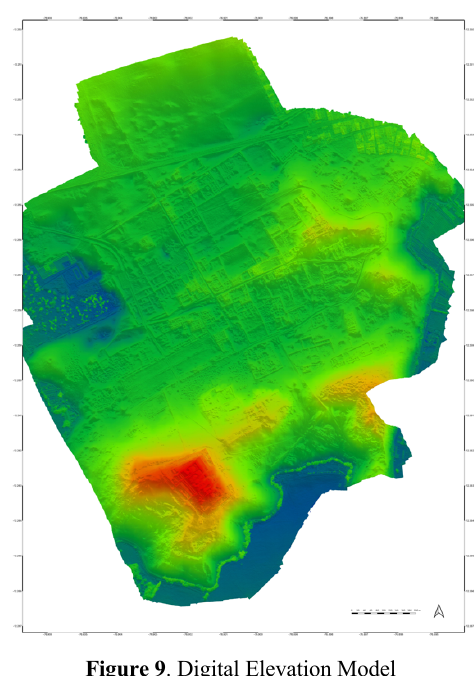
Figure 9 . Digital Elevation Model